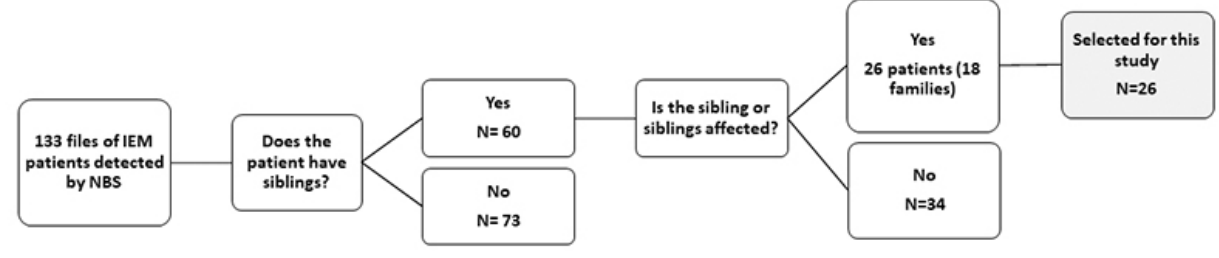
Figure 1. Study algorithm for inclusion of individuals in the present